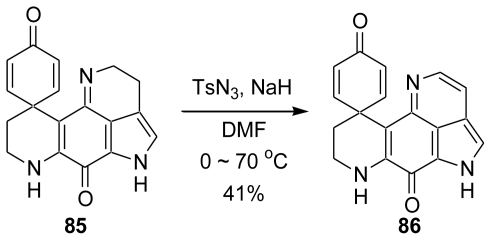
The reaction of N-H spirodienone, TsN3 and NaH.